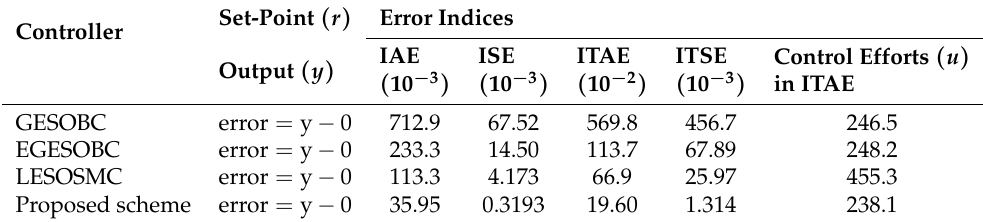
Figure 7. Error dynamics of proposed controller with reaching phase elimination for Example 2. Table 2. Comparison of performance indices for Example 2.